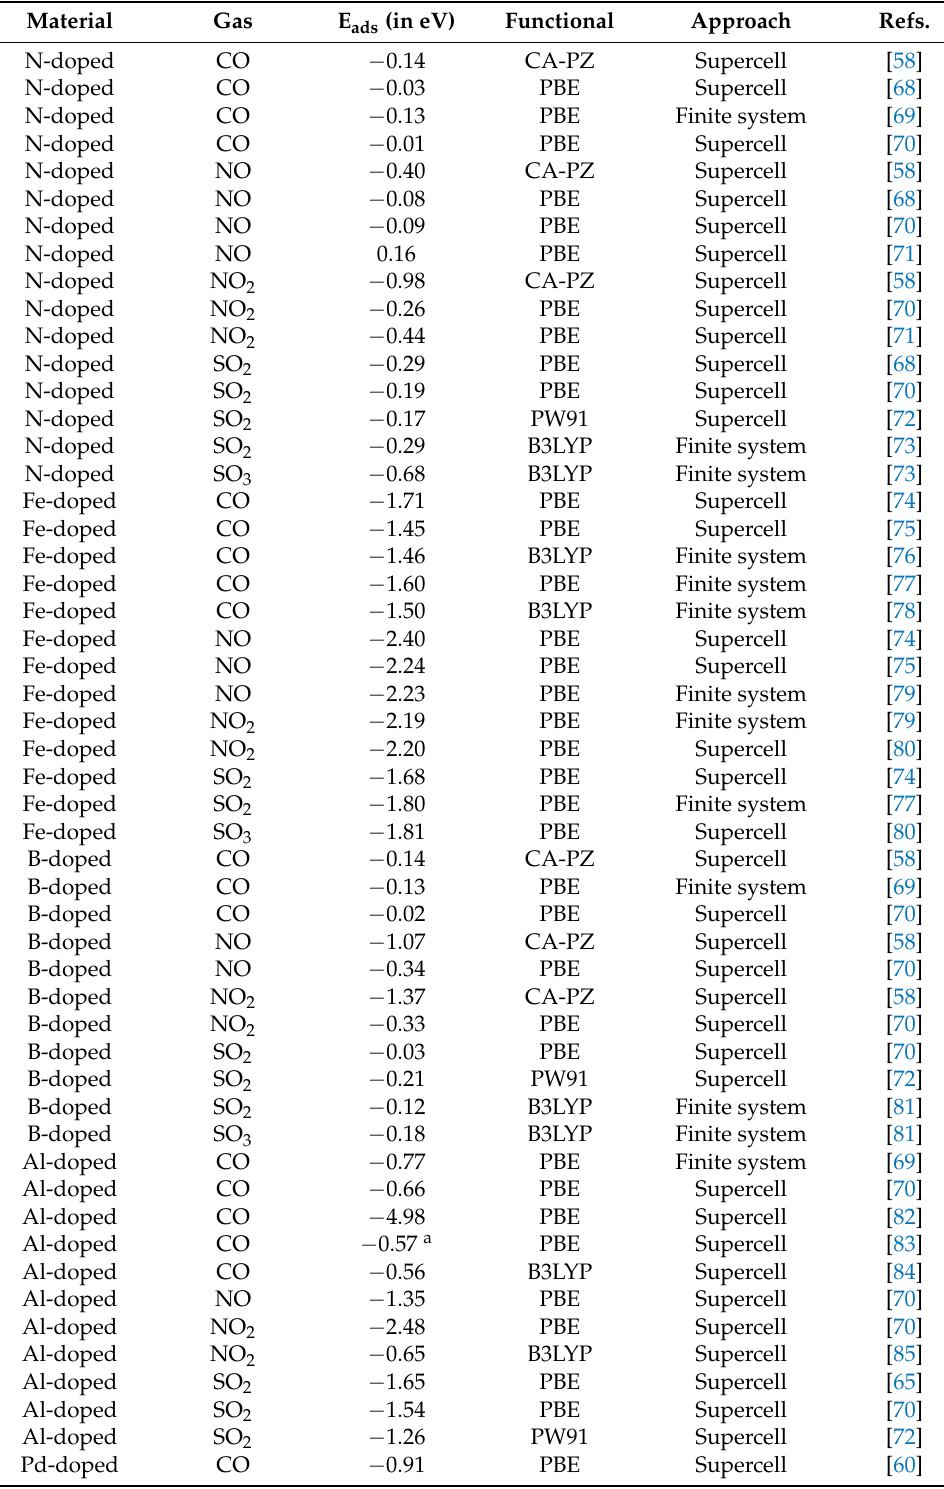
Table 4. Adsorption energies of toxic gases on doped